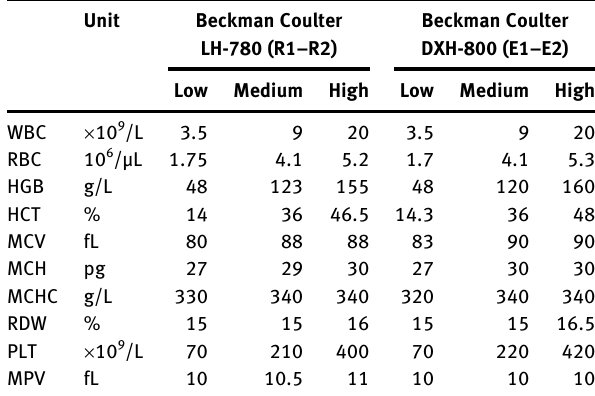
Table  : Internal quality control mean (target) values of